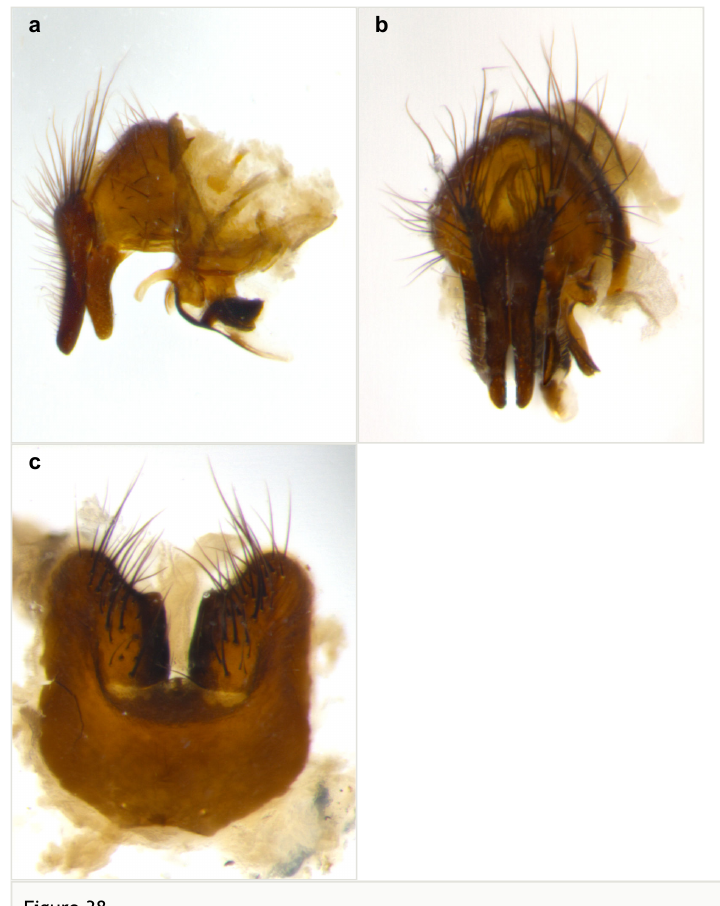
Male terminalia of Calolydella virginiajamesae sp. n. ; a–c : paratype, voucher n.